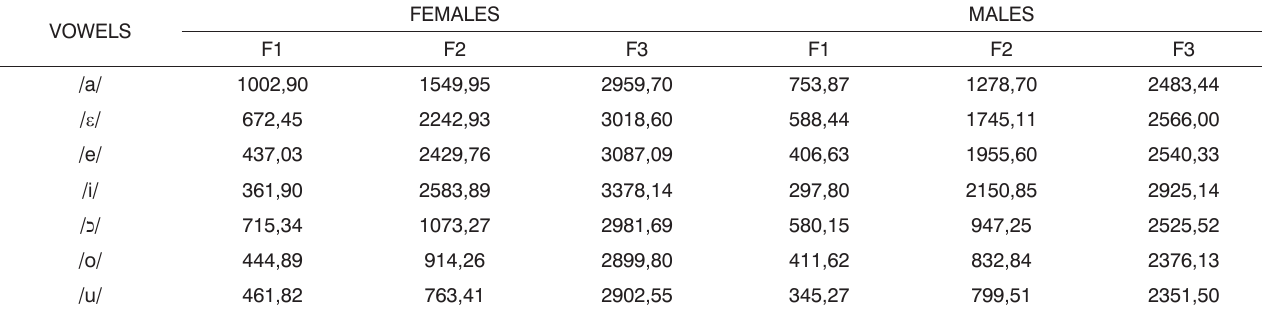
Table 3. Mean harmonic frequency values for the first three formants (F1, F2, F3) in Hz, for each vowel and gender